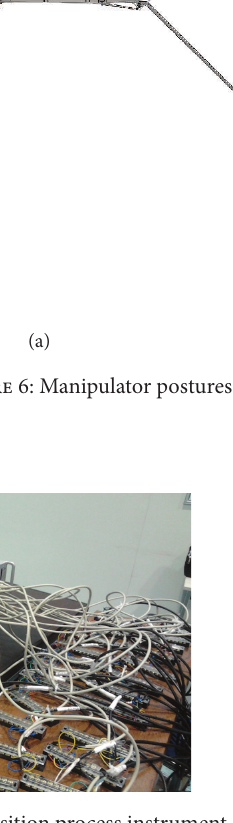
Figure 8: Angle sensor pasted on boom 1 during the